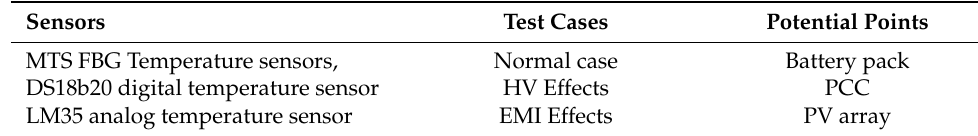
Table 1. The testing data.